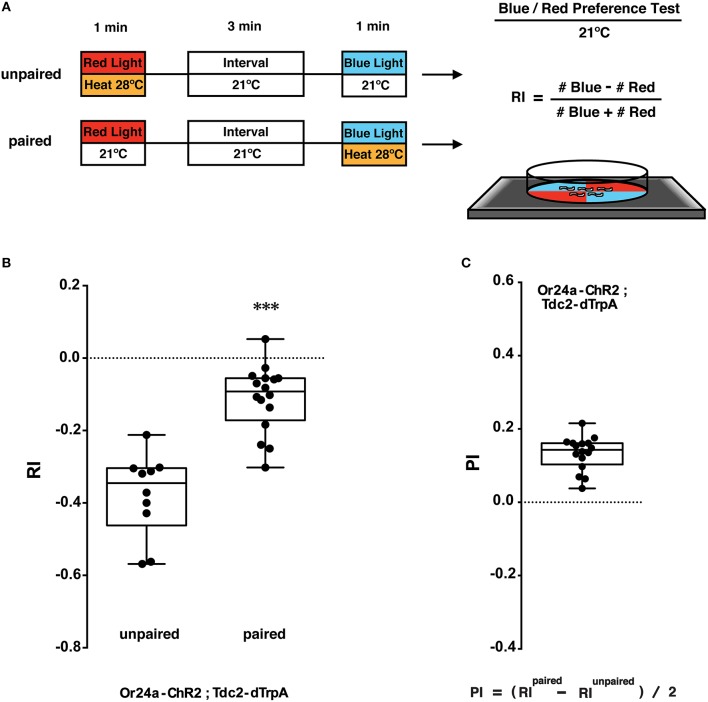
Phototactic tests of larval memory formed with paired presentation of blue light and heat. (A) Larval conditionings and phototaxis test. Transgenic larvae carrying both Or-ChR2 and Tdc2-dTrpA1 were conditioned with heat (28°C) and blue light in either unpaired or paired way. After the first conditioning with red light (60 s), larvae are transferred to an interval plate (21°C), and then transferred to another plate to be illuminated with blue light for 60 s. Heat stimulation was applied during either the first conditioning (unpaired) or the second conditioning (paired with blue light). Larval phototactic behavior was then tested at 21°C on the blue/red quadrants plate. (B) Phototactic responses of transgenic larvae (Or24a-ChR2; Tdc2-dTrpA1) with unpaired and paired conditioning. The paired but not the unpaired conditioning with blue light and heat (28°C) caused significant suppression of negative phototaxis toward blue light. ***p < 0.001 by Mann-Whitney U-test between unpaired and paired group. n = 10–16 trials. (C) Memory performance scores (PI) of the paired conditioning group against the unpaired control. Box plots represent the median as the middle line, 25th and 75th percentile as box boundaries, as well as the minimum and the maximum as whiskers, respectively.